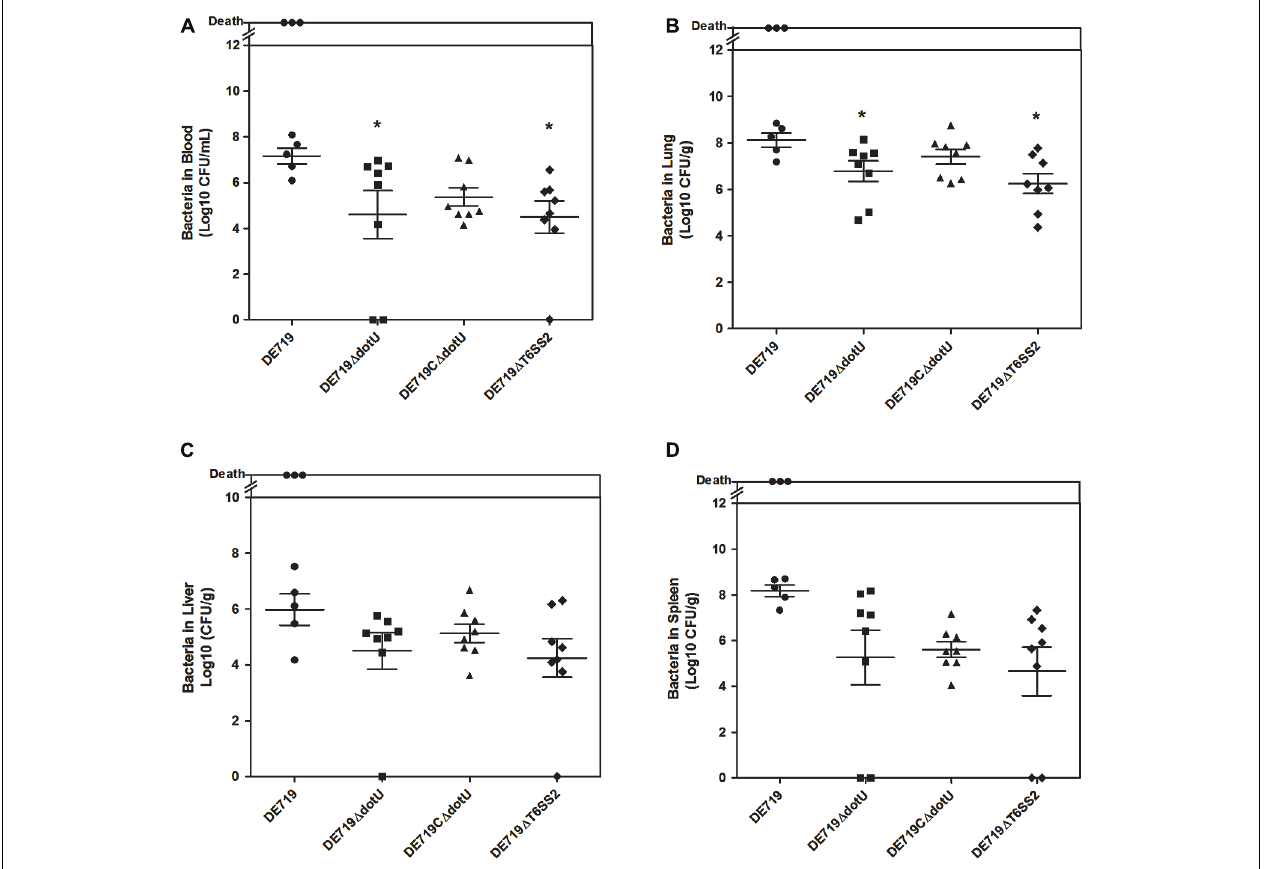
FIGURE 5 |Animal systemic infection experiments. Groups of eight 7-day-old ducks were intratracheally infected with 10 8 CFU bacteria. Bacteria were recovered from blood (A) , lungs (B) , livers (C) , and spleens (D) at 24 h post-infection. * p < 0.05 compared with DE719. Non-parametric Mann–Whitney U-test was carried out for statistical